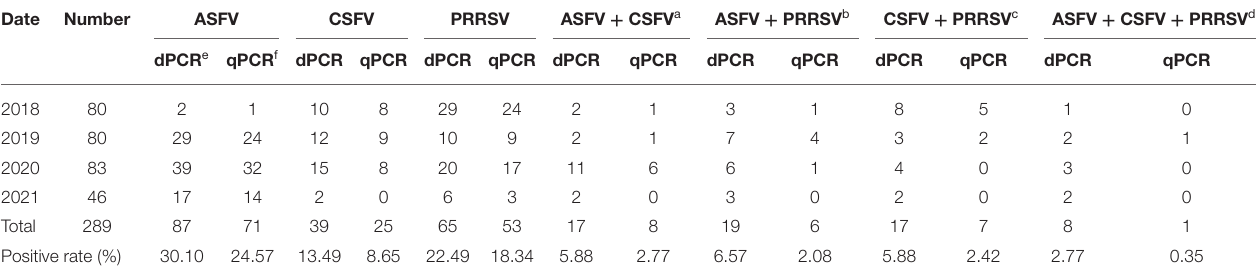
TABLE 5 | Detection results of the clinical samples by the multiplex crystal dPCR and the multiplex qRT-PCR.